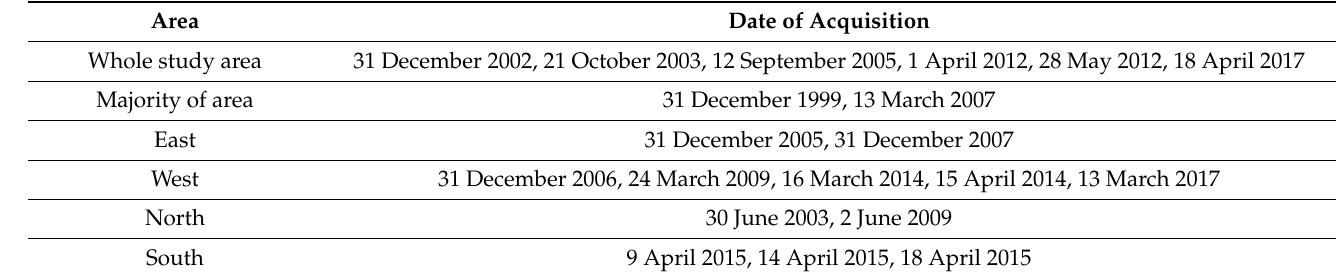
Table 1. Date of acquisition of high-resolution ground truth data covering Swindon between 1999 and 2017, and their respective